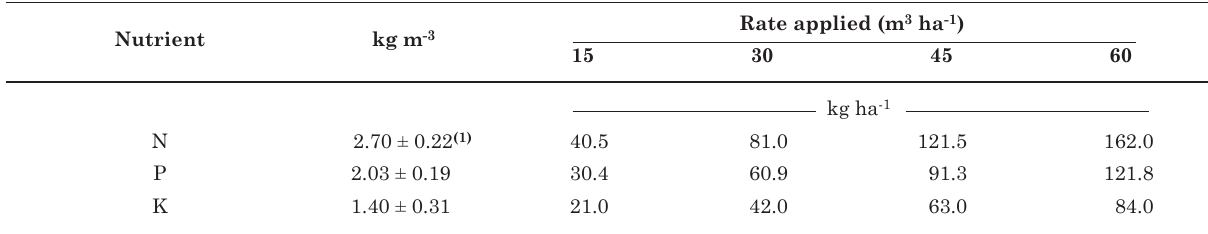
table 3. nitrogen, phosphorus and potassium contents and amounts in the swine slurry applied to corn, wheat, soybean and common bean